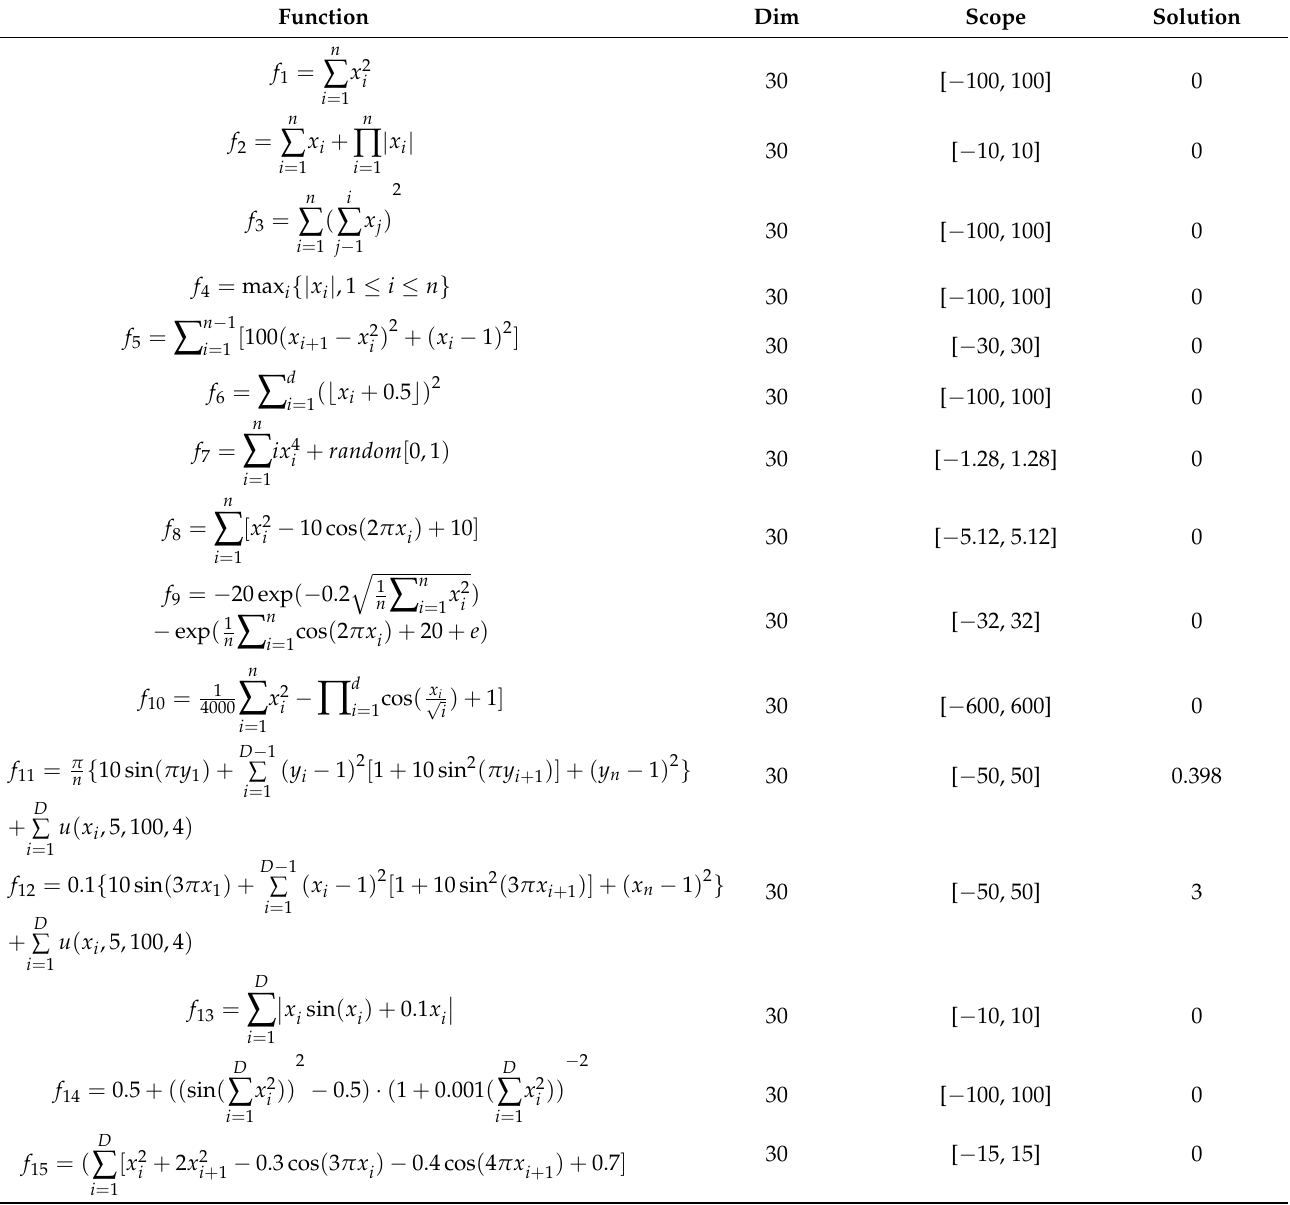
Table 2. Benchmark